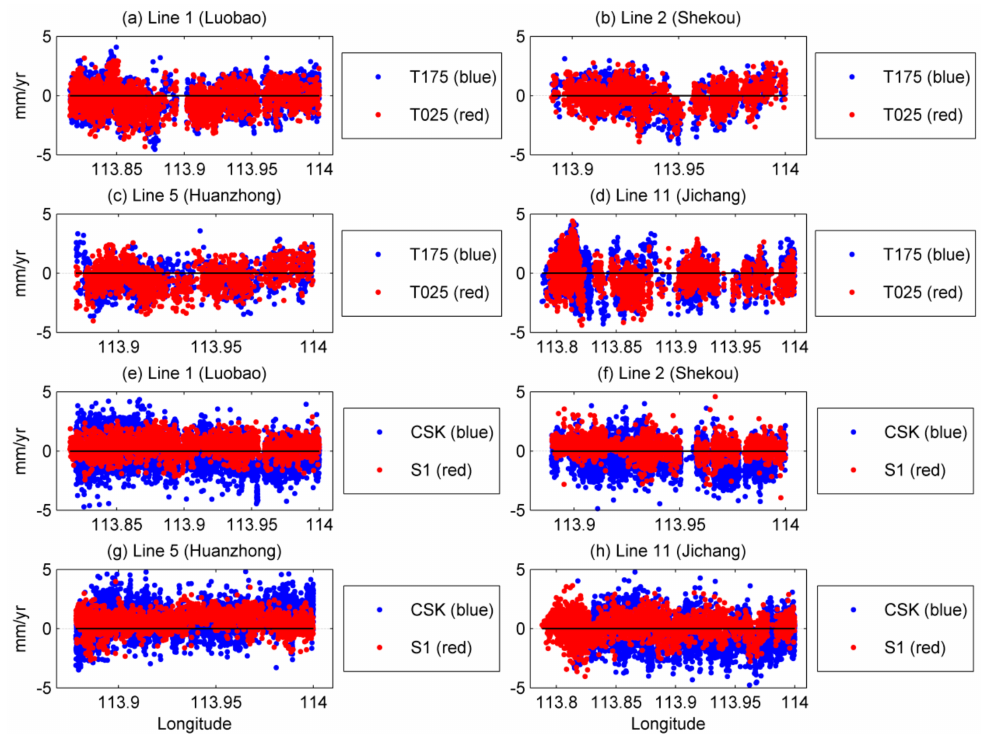
Figure 13. ( a ) Mean rates along Line 1 from T175 and T025 with buffer distance of 250 m to both sides of the subway; ( b – d ) Are the same for Line 2, Line 5, and Line 11 respectively; ( e ) Mean rates along Line 1 from CSK and S1 with buffer distance of 250 m to both sides of the subway; ( f – h ) Are the same for Line 2, Line 5, and Line 11